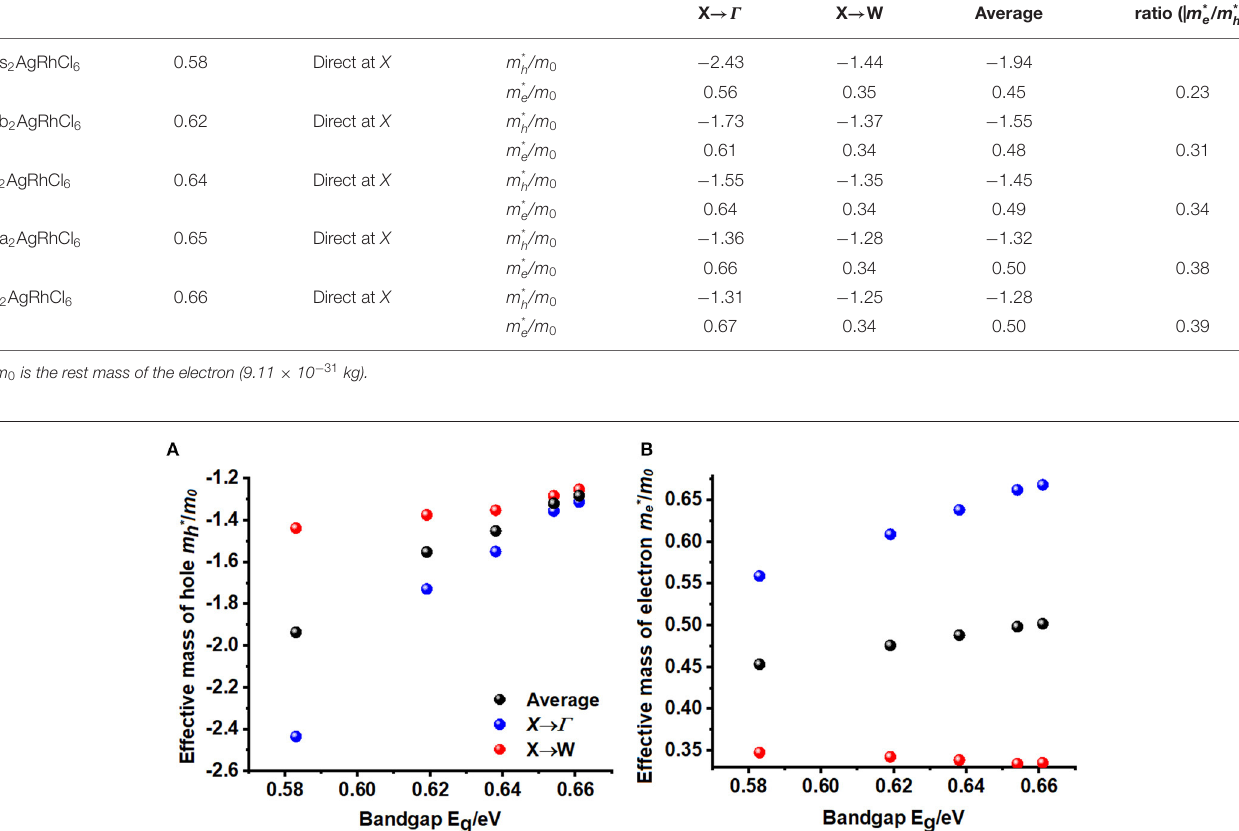
X → Γ X → W Average ratio (| m * e / m * h | )